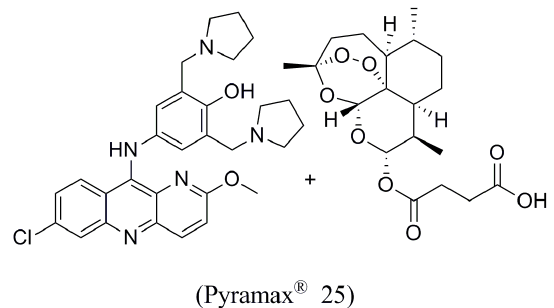
Figure 10 - Structure of drugs used in Pyramax ® combination 25